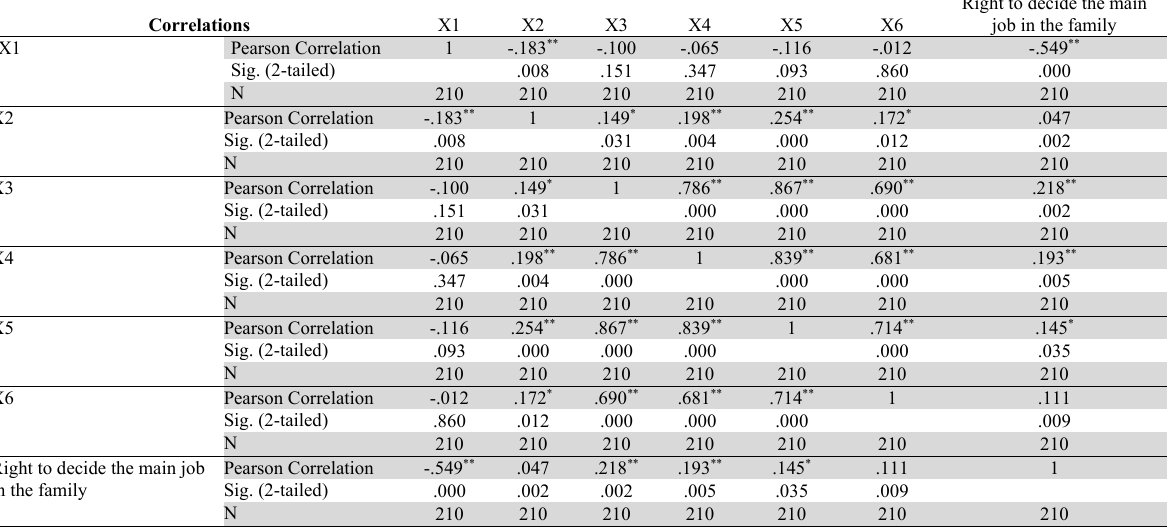
The correlative matrix between variables